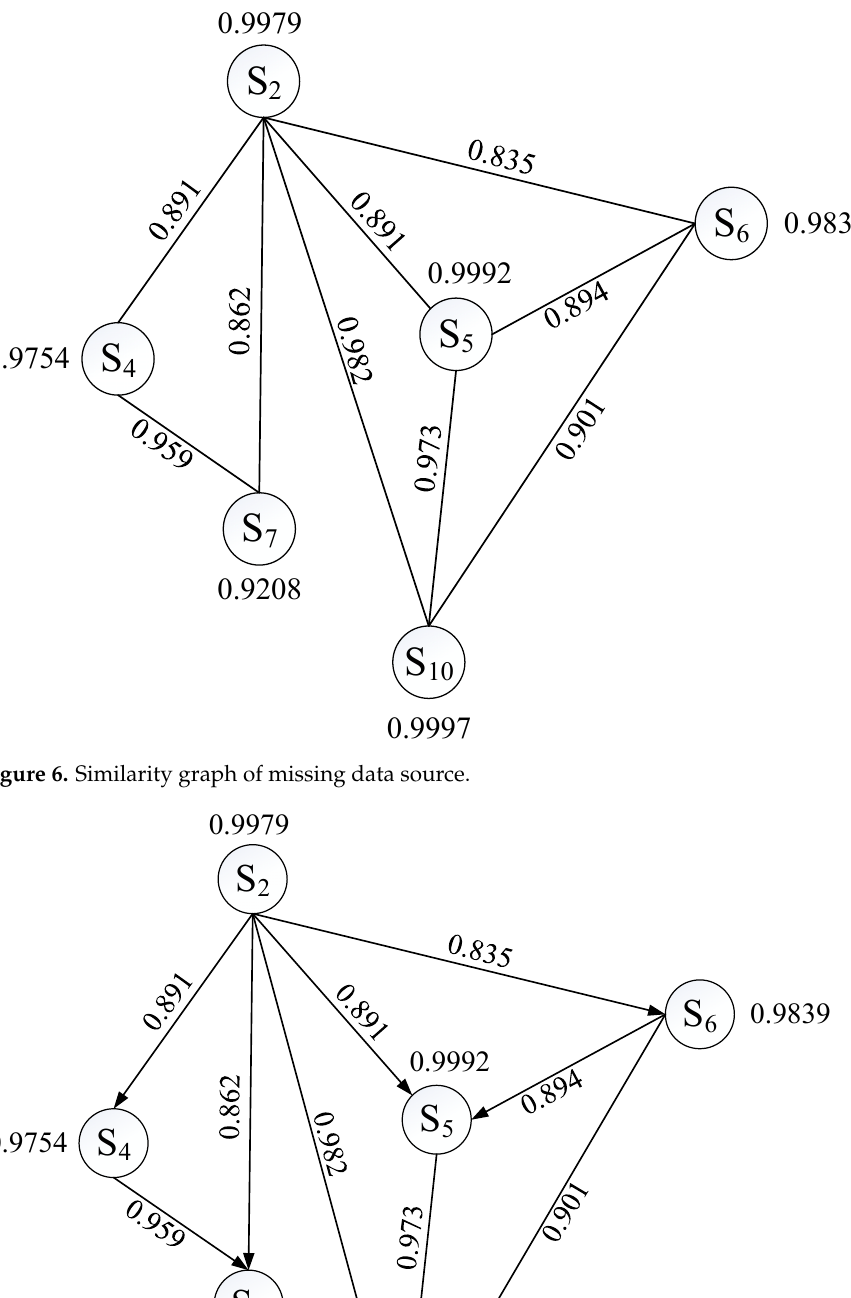
Figure 7. Similarity diagram of directed missing data source. Based on the similarity graph of directed missing data source, the confidence and average filling error of all filling orders are calculated by Equation (16), as shown in Table